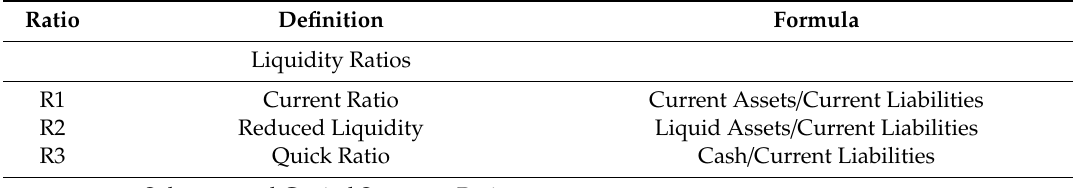
Table 1. Ratios used in the empirical